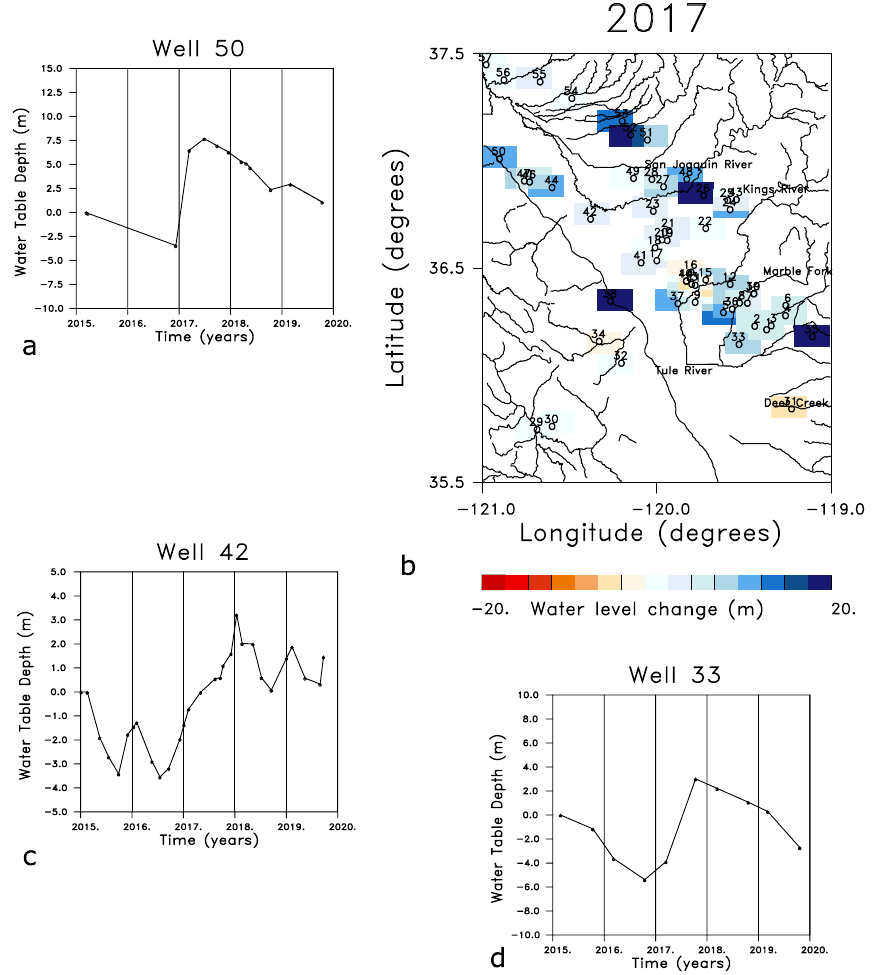
Figure 10. ( a ) Water level changes observed in Well 50, denoted in the location map in panel b. The time series has been reduced by shifting the initial value to zero and removing a linear trend from the data. ( b ) Location map indicating the position of the 57 wells that had at least 10 observations between the start of 2015 and the end of 2020. The colored rectangles denote the changes in the water levels in each well that occurred during the water year 2017 (between October 2016 and October 2017). ( c ) Water level changes in Well 42 obtained after shifting the curve such that the initial value is zero and removing a linear trend. ( d ) Changes in the depth to the water table in Well 33, reduced in the same fashion as the other two wells in this figure. The continuous water table observations are available from the site: https:// data. cnra. ca. gov/ datas et/ conti nuous- groun dwater- level- measu remen ts while the seasonal data may be found at https:// data. cnra. ca. gov/ datas et/ perio dic- groun dwater- level- measu remen ts. The plots were constructed using NCL and NCAR Graphics 6.5.0 (https:// www. earth